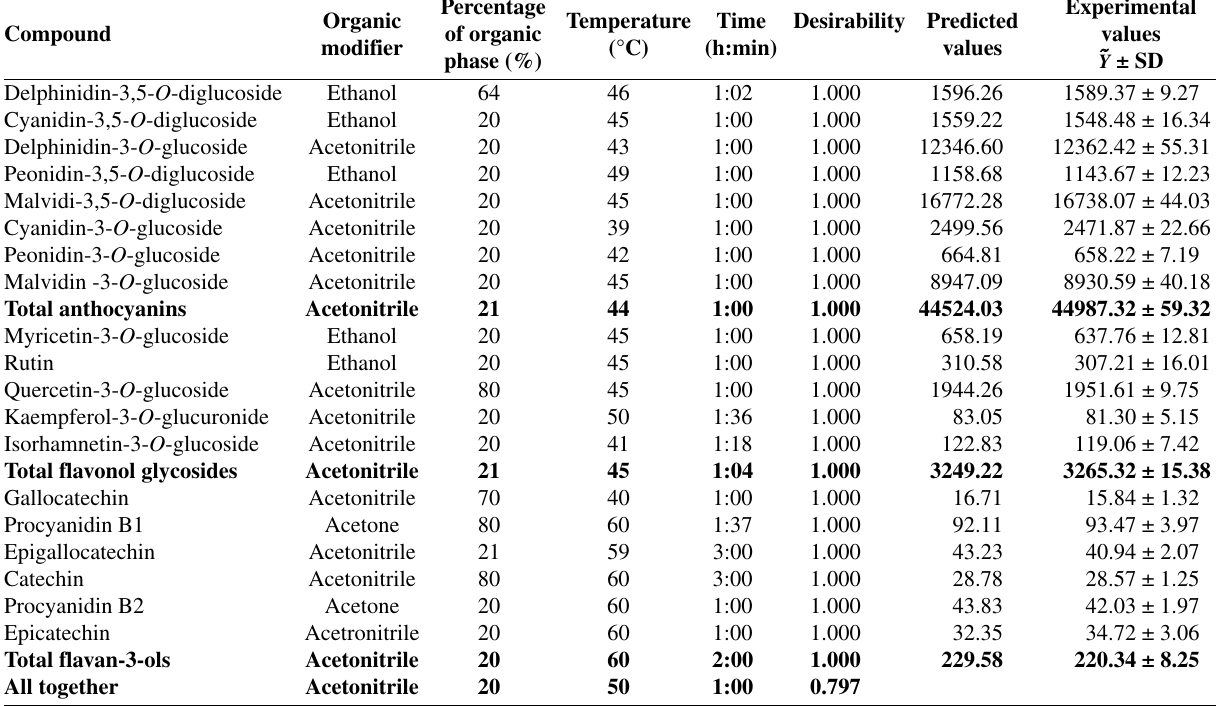
Table 3 . Optimal extraction conditions for the recovery of individual and all together flavonoids determined by response surface methodology. Pre- dicted and experimental values are expressed in mg kg –1 dry weight of grape skin Percentage Organic Temperature Time Desirability Predicted